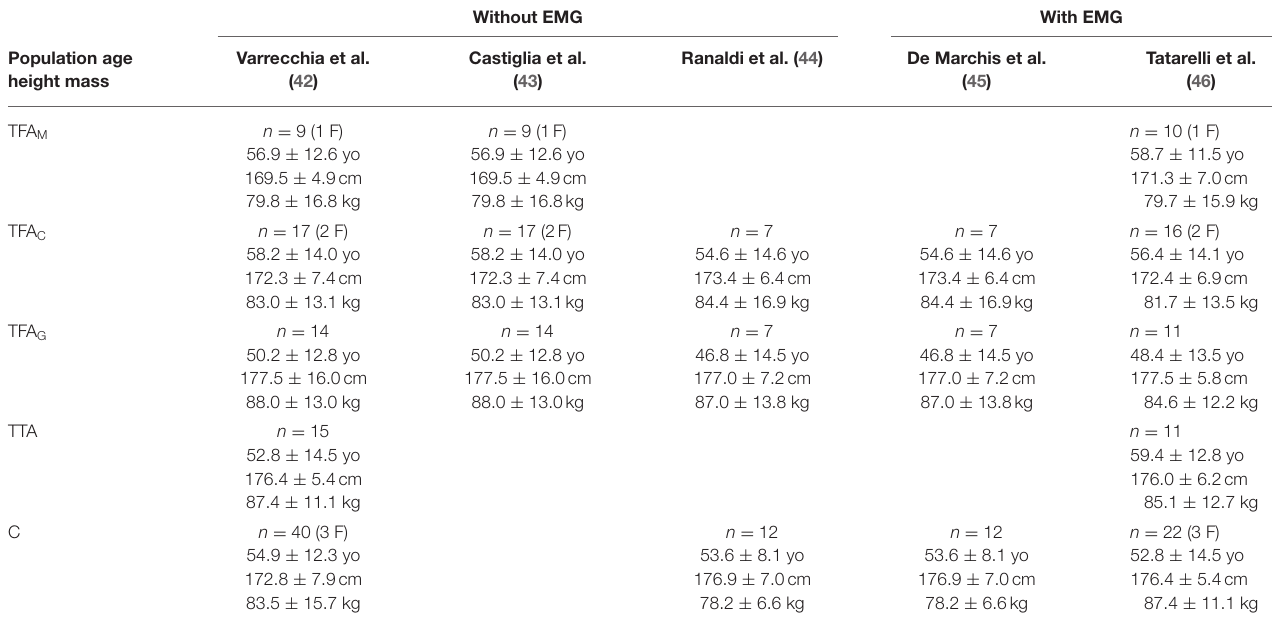
TABLE 1 | Populations characteristics across the 5 studies. Population age height mass